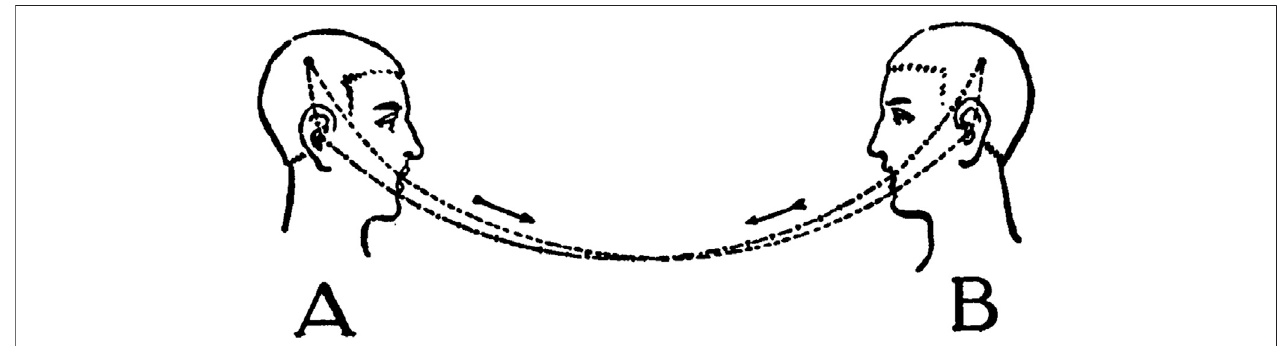
FIGURE 1 | “ Le circuit du langage ” (from Saussure 1967: CLG 60).